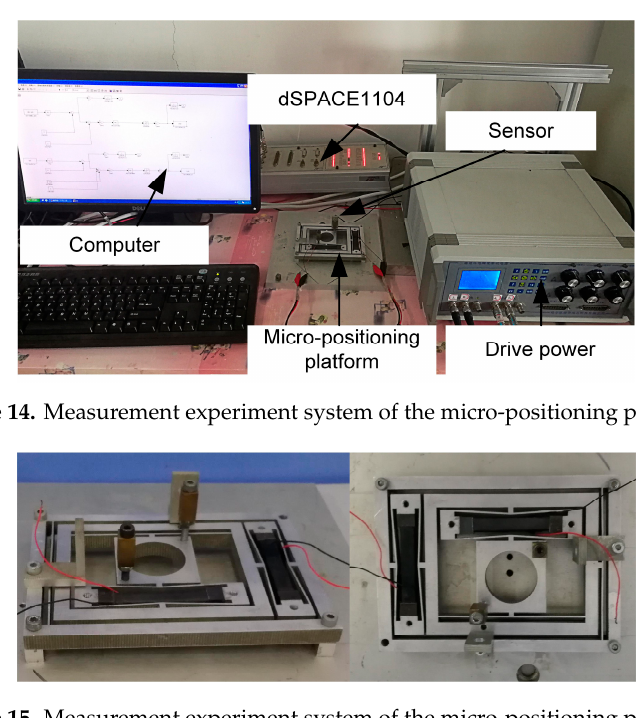
Figure 15. Measurement experiment system of the micro-positioning platform.